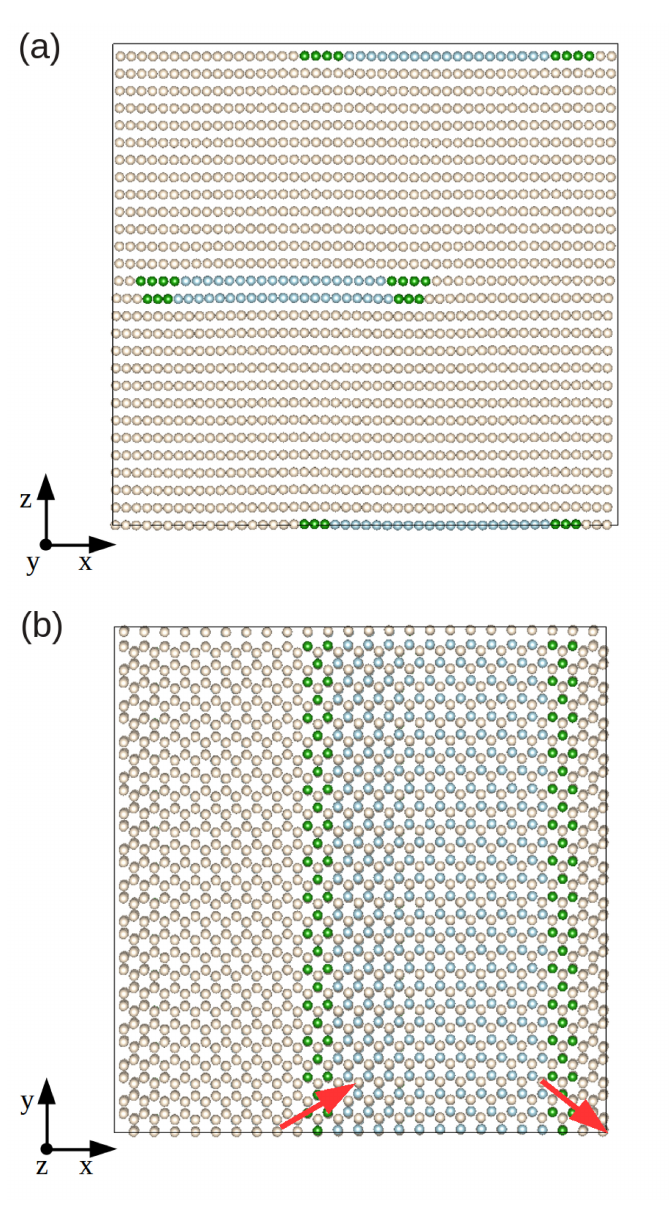
Figure 1. Sketch of a fully relaxed system containing an edge dislocation from different views. Green spheres represent atoms belonging to the dislocation core, blue spheres atoms belonging to the fcc-like stacking fault, and yellow spheres atoms with common hcp atomic coordination features. Red arrows represent the Burgers vectors of the partial dislocations. ( a , b ) represent different views of the simulation